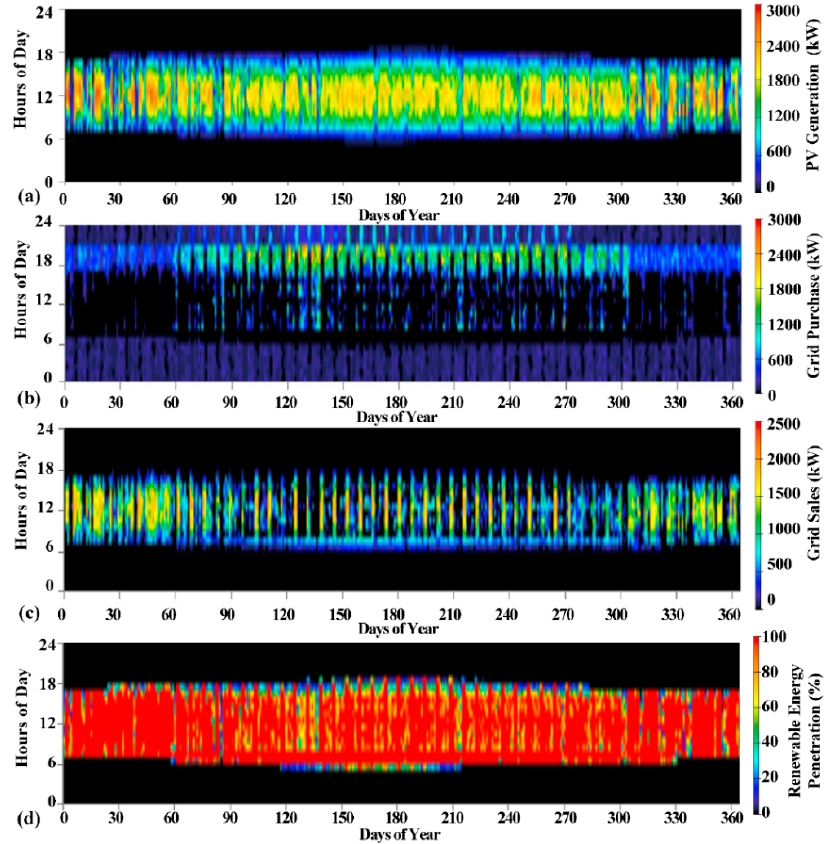
Figure 13. The datamap of the system ( a ) Solar Energy generation in kW ( b ) Energy Purchased from the Grid in kW; ( c ) Energy Sold to the Grid in kW; ( d ) Percentage of Renewable Energy Penetration.